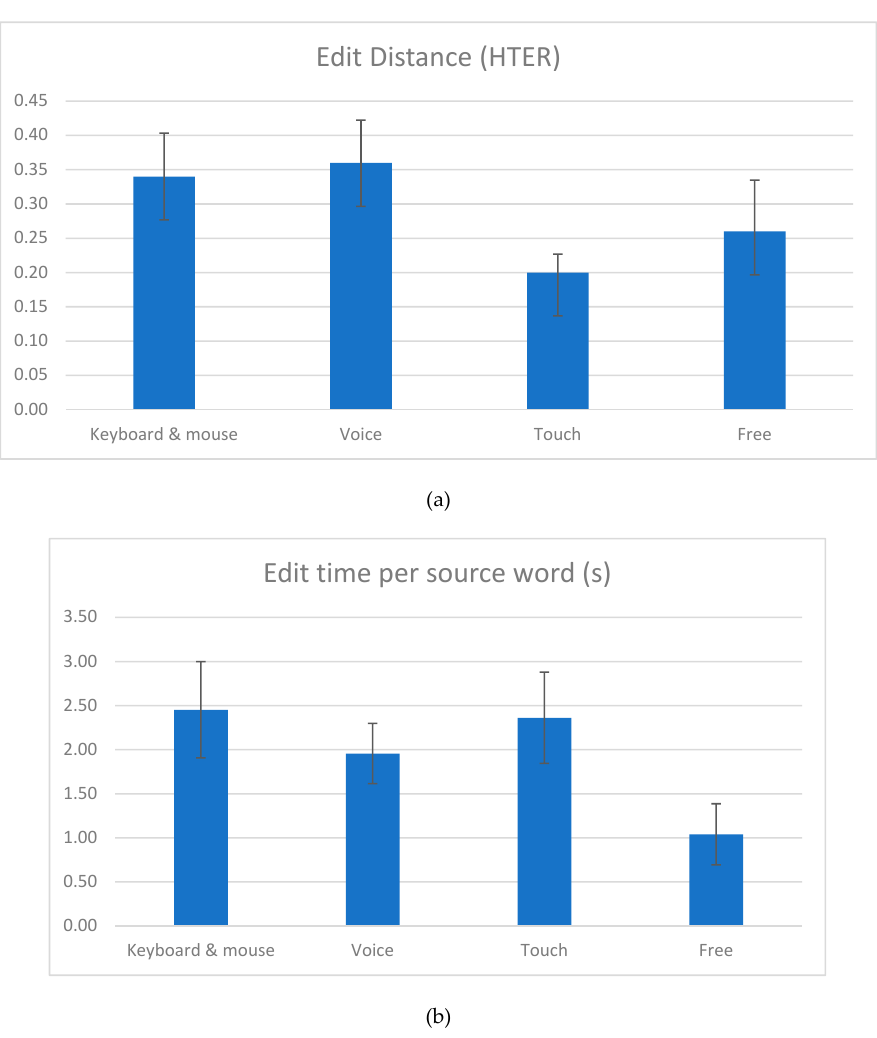
Figure 14. Results for edit distance ( a ) and edit time ( b )—2nd round of tests.